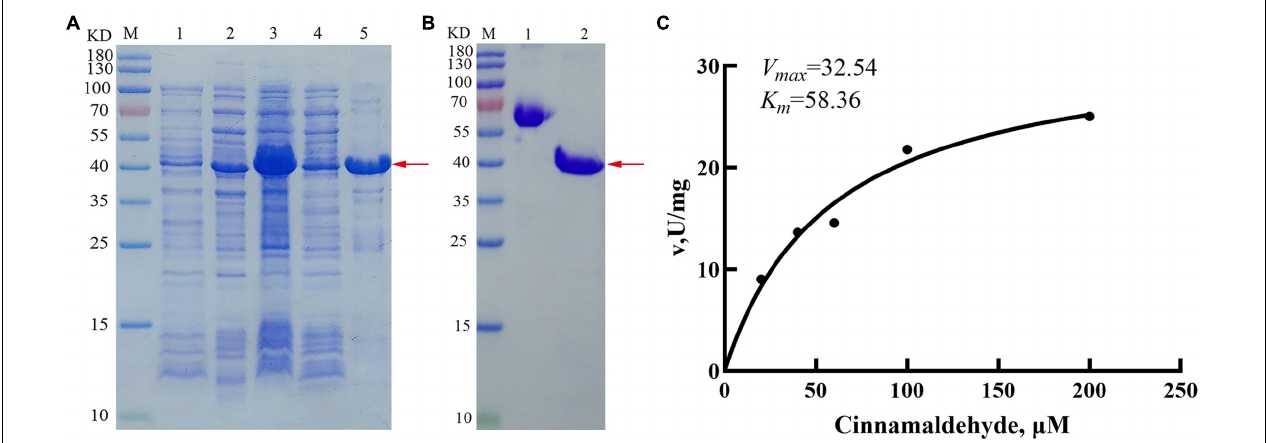
FIGURE 8 | Heterologous expression of PmCAD1 protein in Escherichia coli . (A) Identification of PmCAD1 with SDS-PAGE analysis; M, protein molecular mass standard; 1, Empty vector; 2, PmCAD1 protein without IPTG; 3, PmCAD1 protein with IPTG; 4, supernatant after induction; and 5, precipitation after induction. (B) Protein SDS-PAGE identification. M, protein molecular mass standard; 1, 0.5 mg/ml BSA; and 2, PmCAD1 protein after purification. The red arrow points to PmCAD1 protein. (C) Kinetic parameters for purified